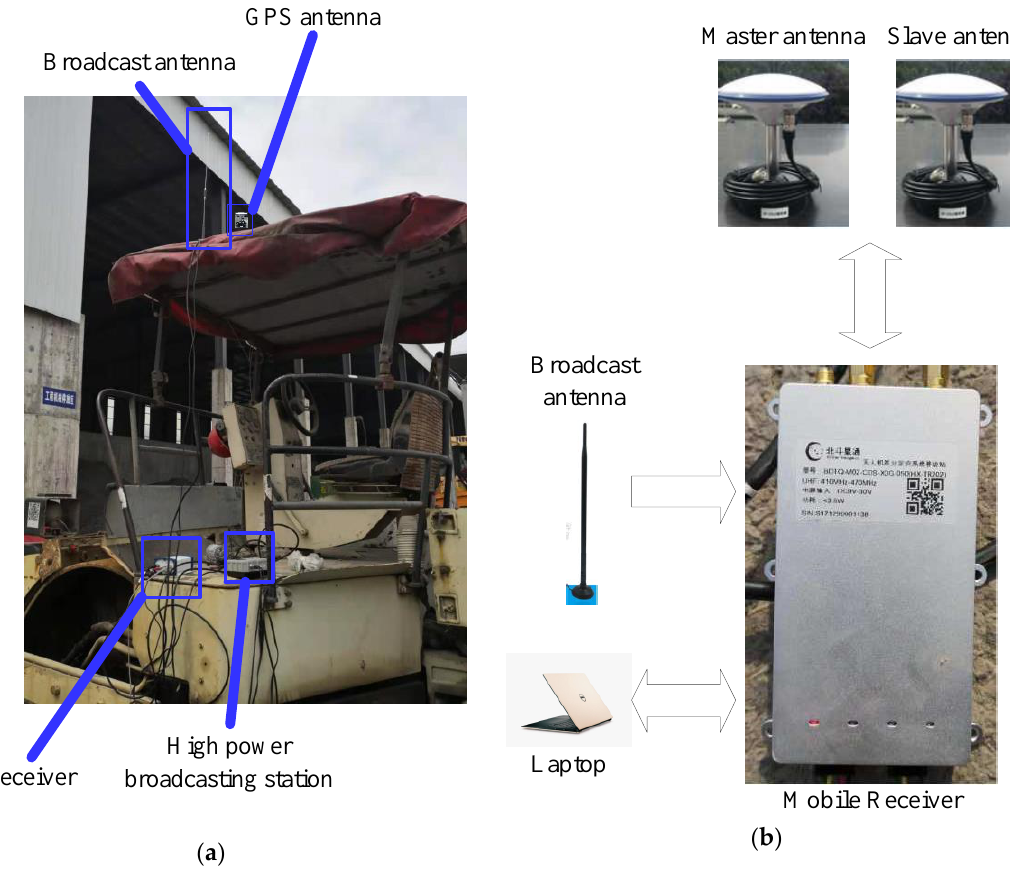
Figure 5. ( a ) Base station and transmitting station; ( b ) Mobile station.